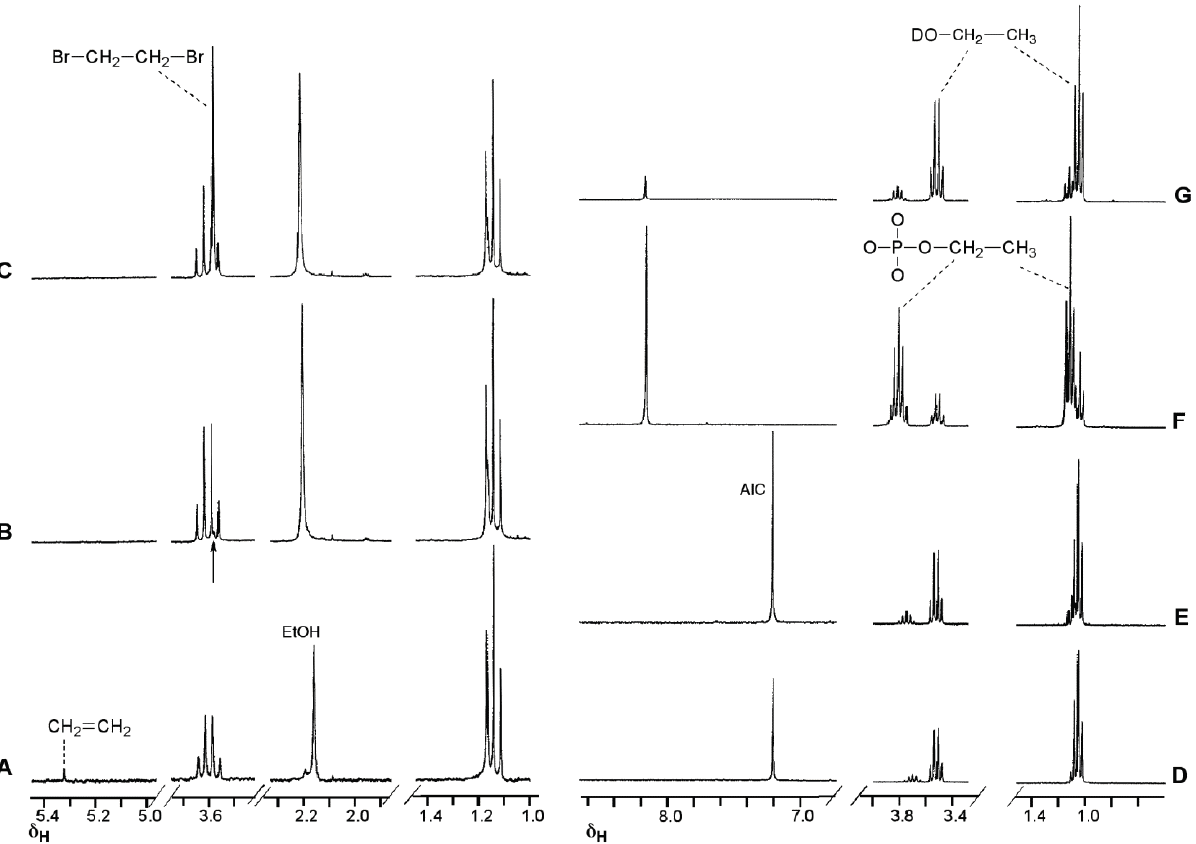
Figure 4. 1 H-NMR investigation of the reaction of ETZ with phosphate buffer (pH 7.8) in a two phase system (D O/CDCl ). Spectra A–C CDCl layer, spectra D–G, D O 2 3 3 2 layer. ( A ) At the end of the imidazotetrazine hydrolysis reaction identifying the putative ethene peak; ( B ) after addition of Br , the arrow indicates the position of a new peak; ( C ) 2 sample of spectrum B after adding authentic dibromoethane; ( D ) at the end of the imidazotetrazine hydrolysis reaction; ( E – G ) sample of spectrum D after sequentially spiking with authentic AIC, ethylphosphate and ethanol (note the shift in the AIC signal after adding the acidic ethyl